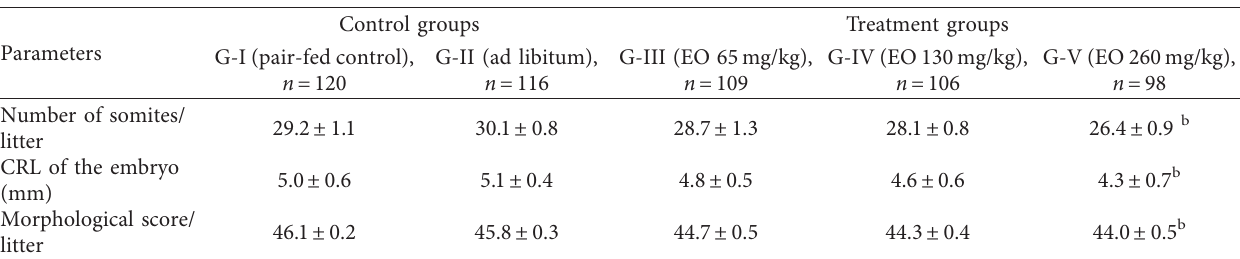
Figure 1: Number of implantation and resorption sites: (a) ( ad libitum control), (b) (65mg/kg), (c) (130mg/kg), and (d) (260 mg/kg). I, implantation site; R, resorption site. Table 2: Embryonic growth following administration of the essential oil of Thymus schimperi